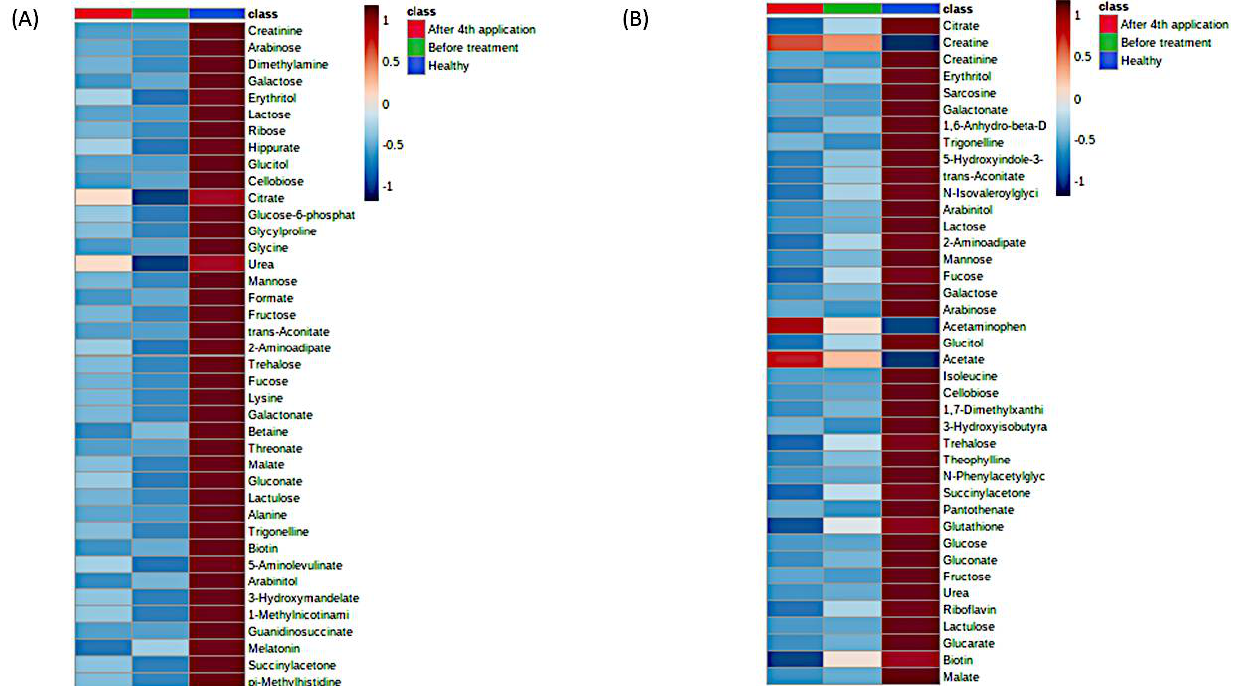
Figure 2. MetaboAnalyst heatmaps of urine 1H-NMR metabolomes representing existing differences between SMA cohort (before and after) and healthy cohort, for males ( A ) and females ( B ). The differences on metabolic level between the before- treatment (green) and after 4th application (red) groups were not significant due to the large variability in SMA samples. The most differentiating metabolites were selected by the PLSDA variable importance in projection (VIP) score, where decreasing metabolites were presented with negative values (blue color) and increasing metabolites were presented with positive values (red color). Individual data are presented in the Supplementary Material (Figures S7 and S8).